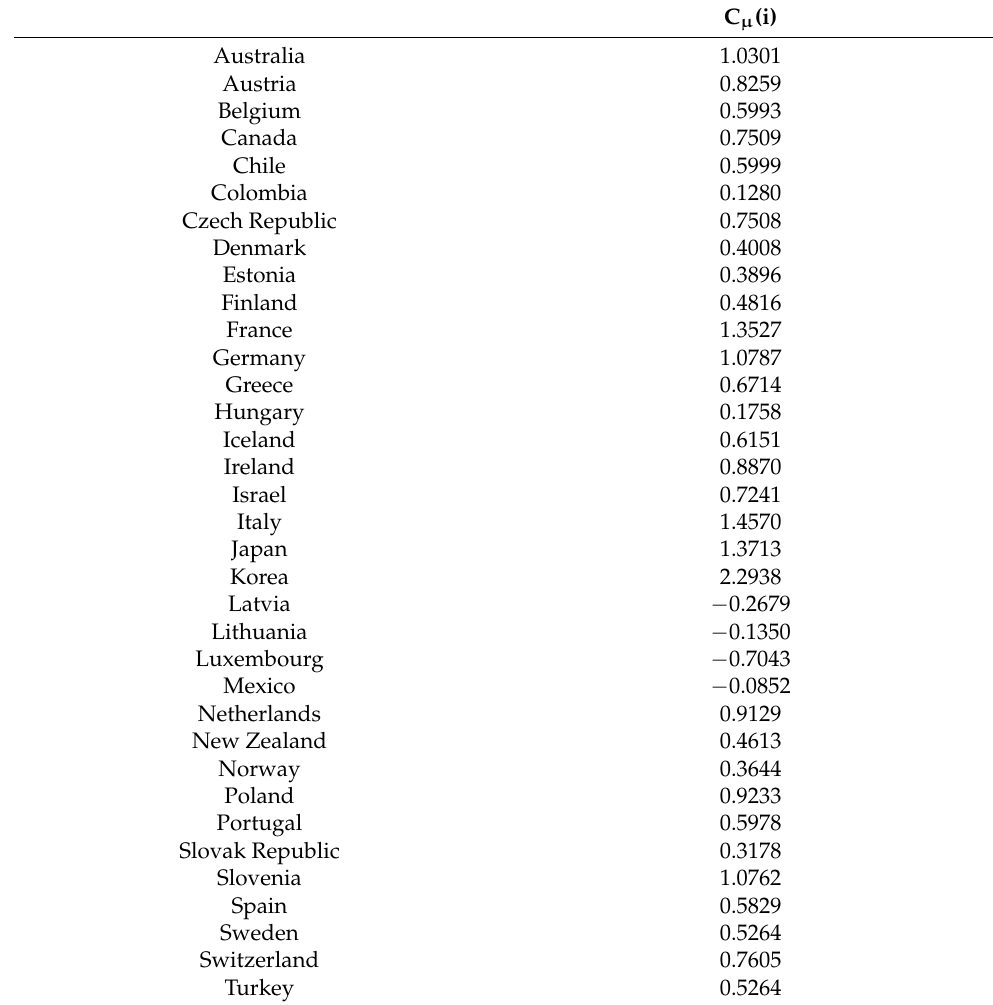
Table 6. The Table 6 expresses the Choquet Integral index of the 35-countries study. The specific value is obtained by the formula